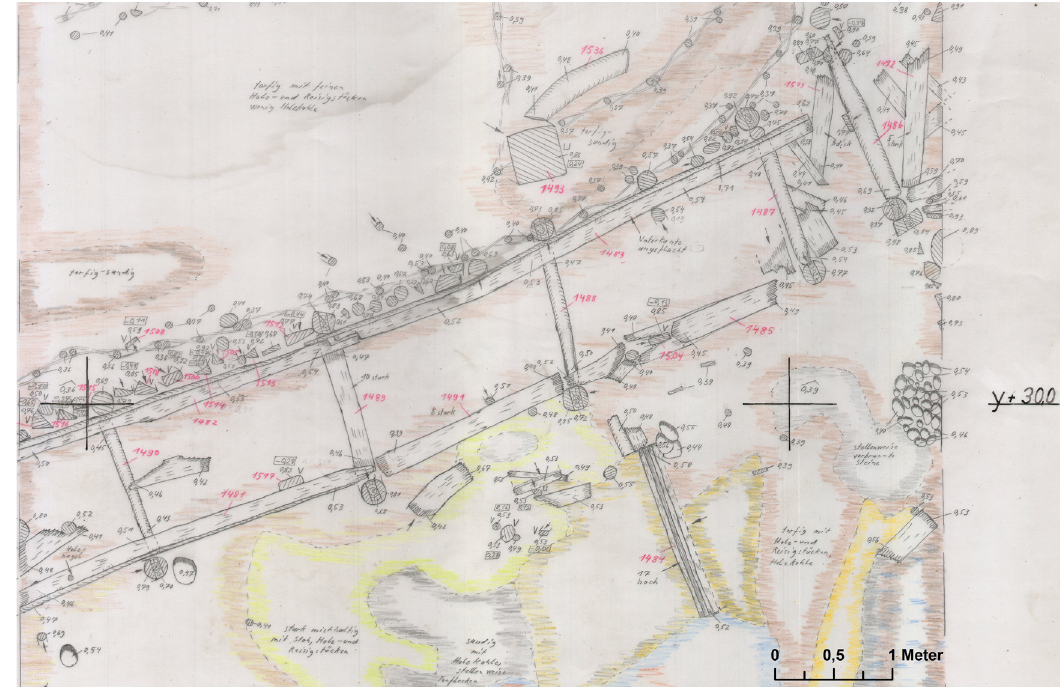
Figure 3: Extract of a planum drawing from trench 9 of the Plessenstraße 83/3 excavation ( Archive of the Archaeological Museum Schloss Gottorf )